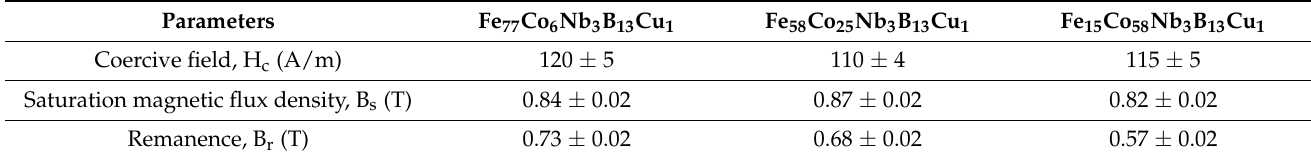
Figure 4. Hysteresis loops for Fe 83 − x Co x Nb 3 B 13 Cu 1 (x = 6 (a), 25 (b), and 58 (c)) alloys annealed at 750 K for 10 min. Table 1. Magnetic properties of Fe 83 − x Co x Nb 3 B 13 Cu 1 (x = 6, 25, and 58) alloys annealed at 750 K for 10 min.